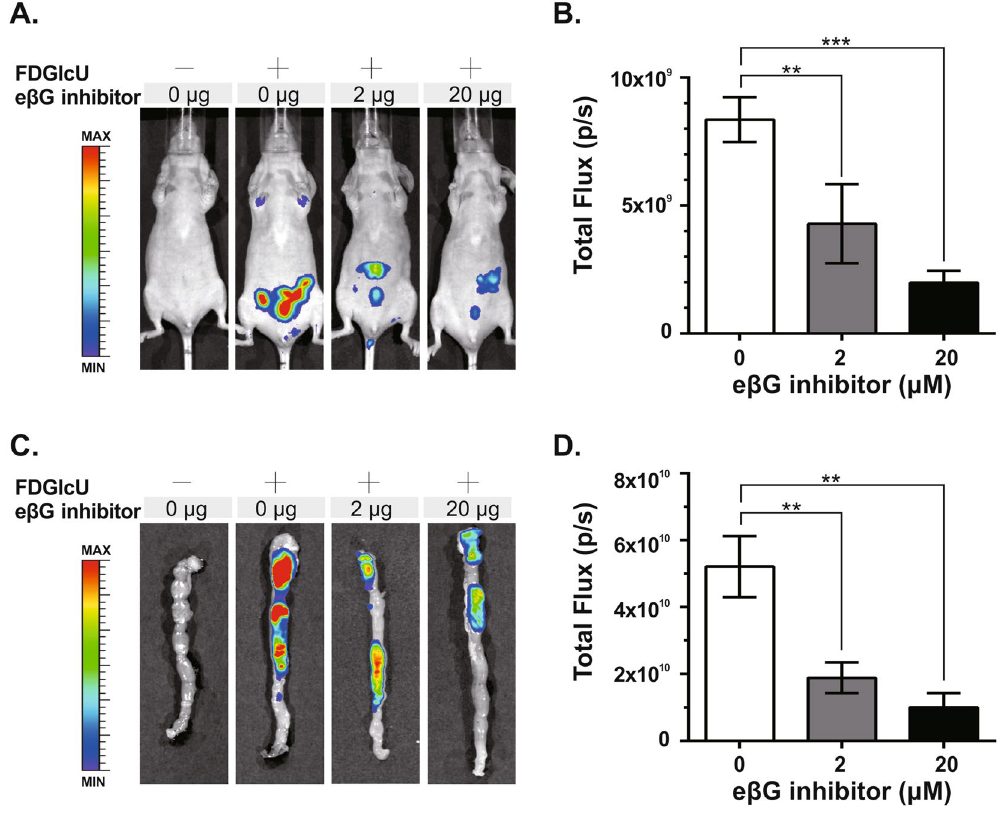
Figure 3. Optical imaging of inhibition of intestinal bacterial β G by the e β G inhibitor. ( A ) Mice were gavaged with the e β G inhibitor (0 μ g, 2 μ g, or 20 μ g) 4 hours before FDGlcU administration, then whole-body imaging was performed 3 hours later. Control mice were gavaged with vehicle solution. ( B ) The fluorescent signal from the murine abdomens of each group (n = 6) was measured. ( C ) Imaging of excised large intestines after whole- body imaging at the 3-hour time point. ( D ) The fluorescent signal from the intestines of each group (n = 6) was measured. Error bars indicate SEM. ** P value < 0.01. *** P value <